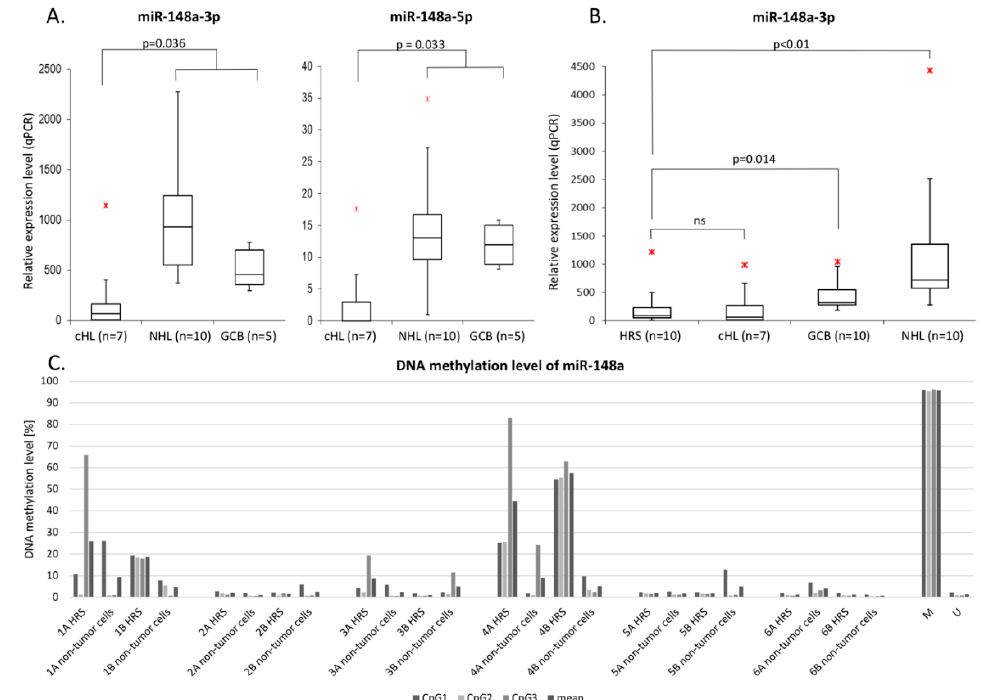
Figure 3. ( A ): Validation of mir-148a-3p/5p downregulation by real-time qPCR in cHL cell lines ( n = 7)